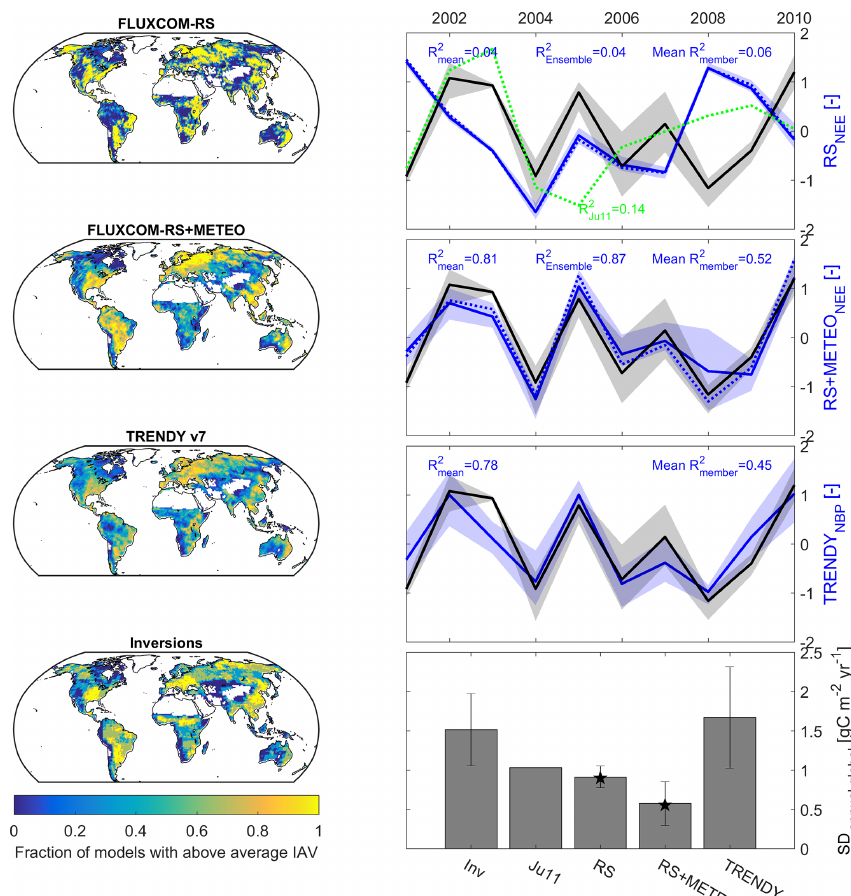
Figure 8. Interannual variability patterns of FLUXCOM NEE, TRENDY NBP and NBP from three atmospheric inversions for the period 2001–2010. Maps show the fraction of respective ensemble members with above-average interannual variability (standard deviation of annual values multiplied with land area). Time series plots show detrended globally integrated annual NEE or NBP anomalies normalized by their standard deviation. The black line is the mean of three inversions and the grey shading indicates their range. The blue solid lines are the means of the considered ensembles; the blue dashed lines are the FLUXCOM ensemble products. R 2 values refer to the comparison with the mean of inversions (black solid line). The bar chart in the bottom right panel shows the standard deviation of detrended annual NEE or NBP for different data sets, averaged over the ensemble members, and the error bar indicates the standard deviation of the ensemble members. Black stars for FLUXCOM refer to the value for the ensemble